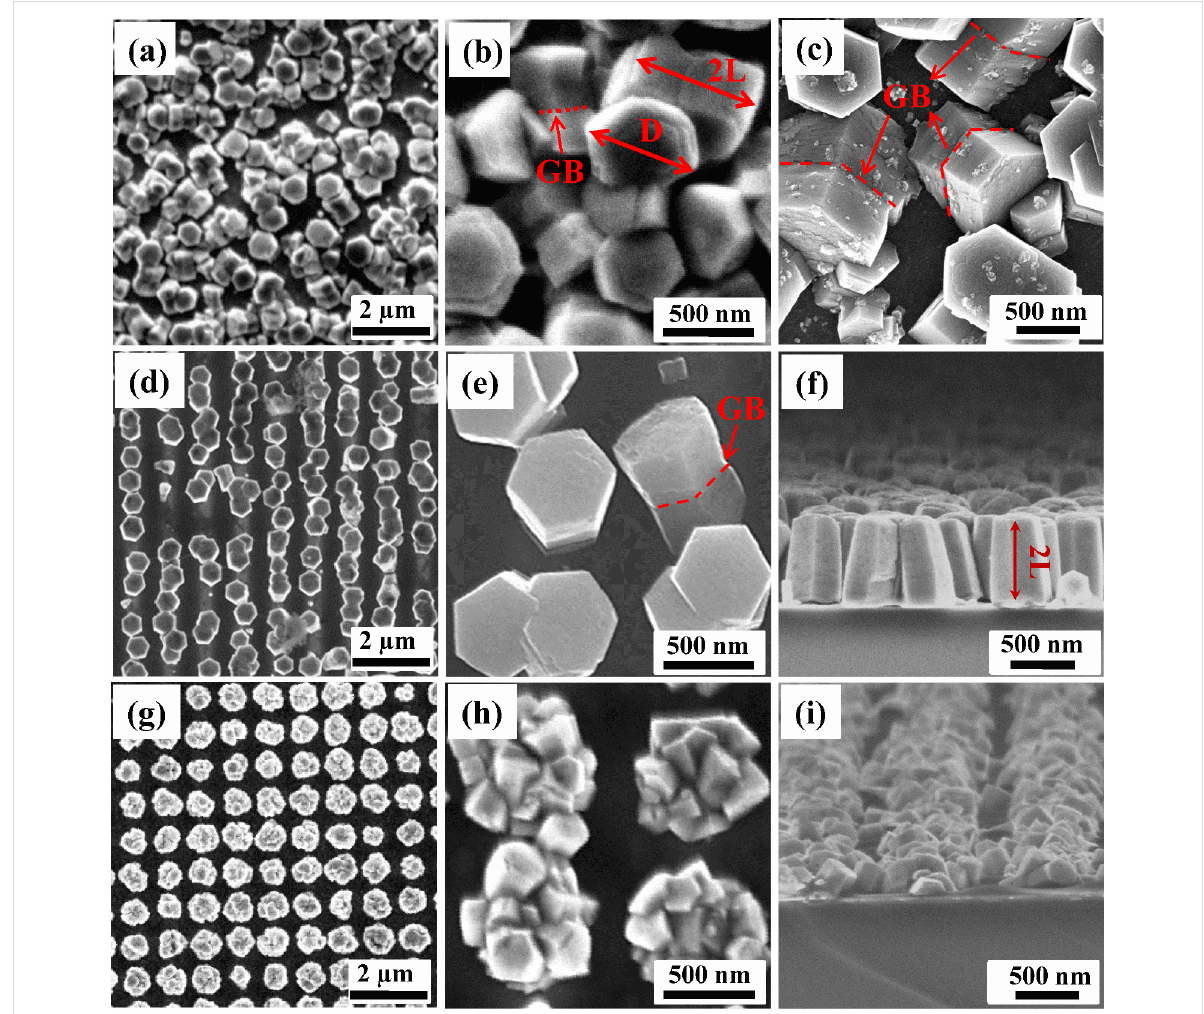
Figure 2: Top view FESEM images of ZnO NCs for (a, b, c) SB (on bare ITO) (d, e) S600 (on patterned ITO with pore size ≈ 600 nm), (g, h) S200 (on patterned ITO with pore size ≈ 200 nm) at low magnification and at high magnification; and the cross-sectional view for (f) S600 (i) S200,